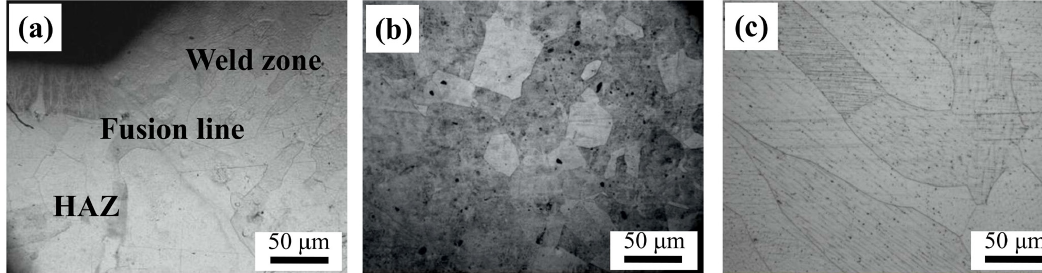
Figure 6. Microstructure in different regions of wire-filled PAW joint(a)welded joint (b)heat affected zone (c)weld zone.